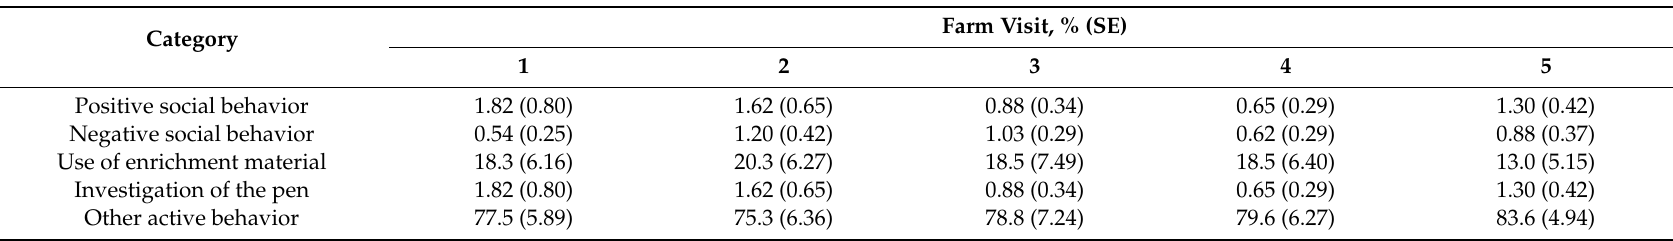
Table 6. Mean values (%) and standard errors (SE) of the five farm visits (1–5) for the categories of the behavioral observations by instantaneous scan sampling.